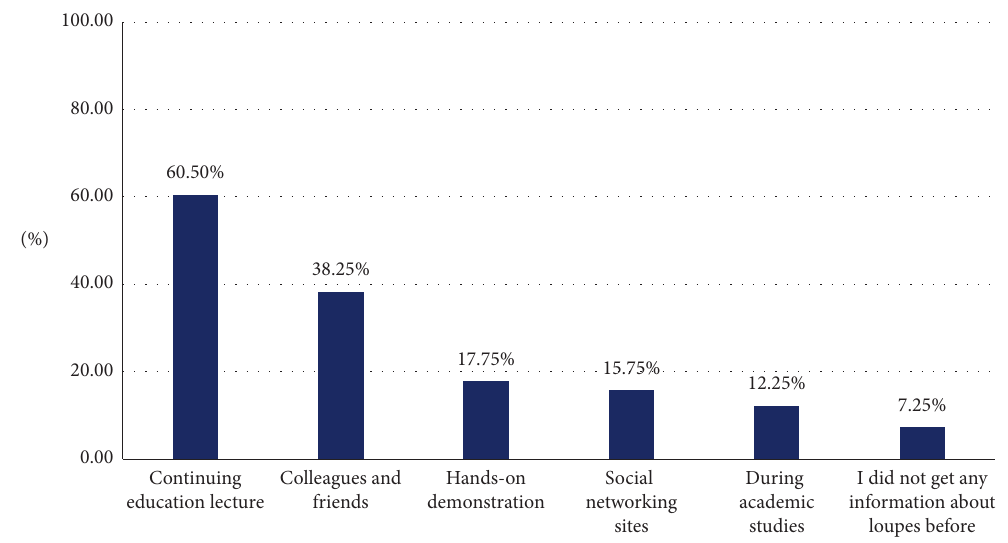
Figure 1: Participants’ sources of information about dental loupes. Table 3: Advantages and disadvantages of using dental loupes.